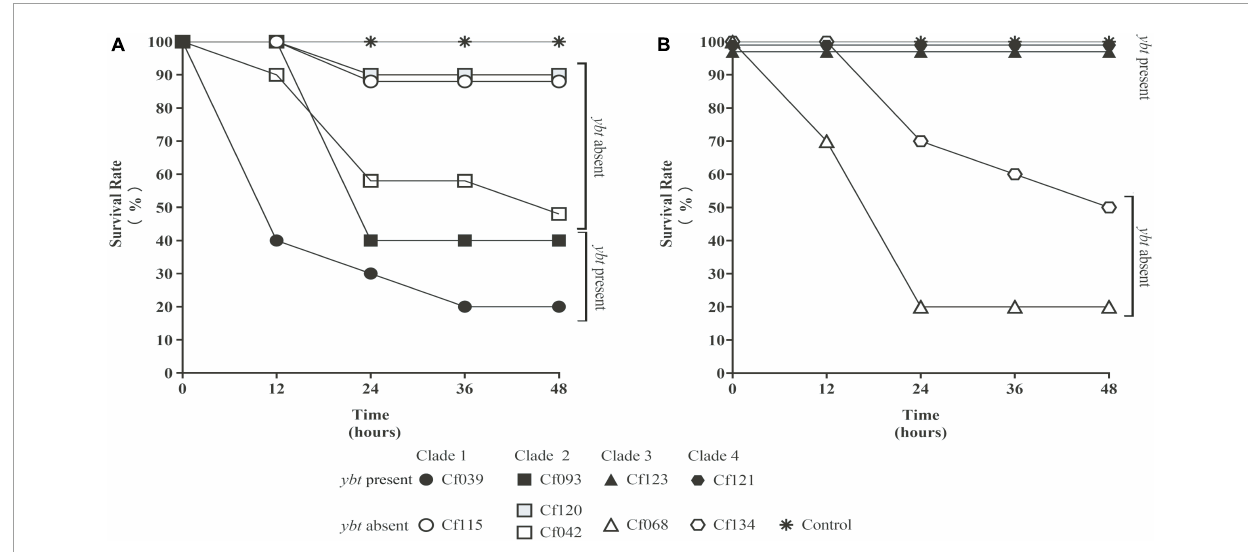
FIGURE4 The survival rate of Galleria mellonella larvae. The solid black symbol represents C. freundii carrying ybt . The hollow white and gray symbol represent ybt -negative strains. The same shape represents the strains within the same clade. The values were fine-tuned to differentiate the folds with the same survival rate. All results were rounded to the nearest integer values. Strains with ybt had a lower (A) or higher (B) survival